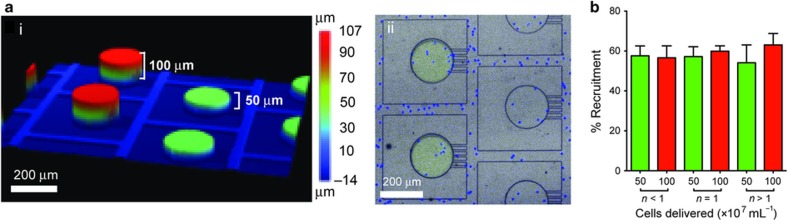
Neutrophil recruitment to formyl-methionyl leucyl-phenylalanine (fMLP) occurs over long distances and is not effected by scavenging of chemoattractant. (a) Profile of the split wafer fabricated for studying neutrophil scavenging. (i) Wafer profile as measured by optical profilometry. (ii) Direct comparison of neutrophil (Hoechst, blue) recruitment toward adjacent reservoirs containing different volumes of fMLP (traced with fluorescein, green) in polydimethyl-siloxane device. (b) Neutrophil chemotaxis with two different volumes (V and 2V) of chemoattractant at different cell densities. (N=3. Error bars=mean±standard error of the mean).